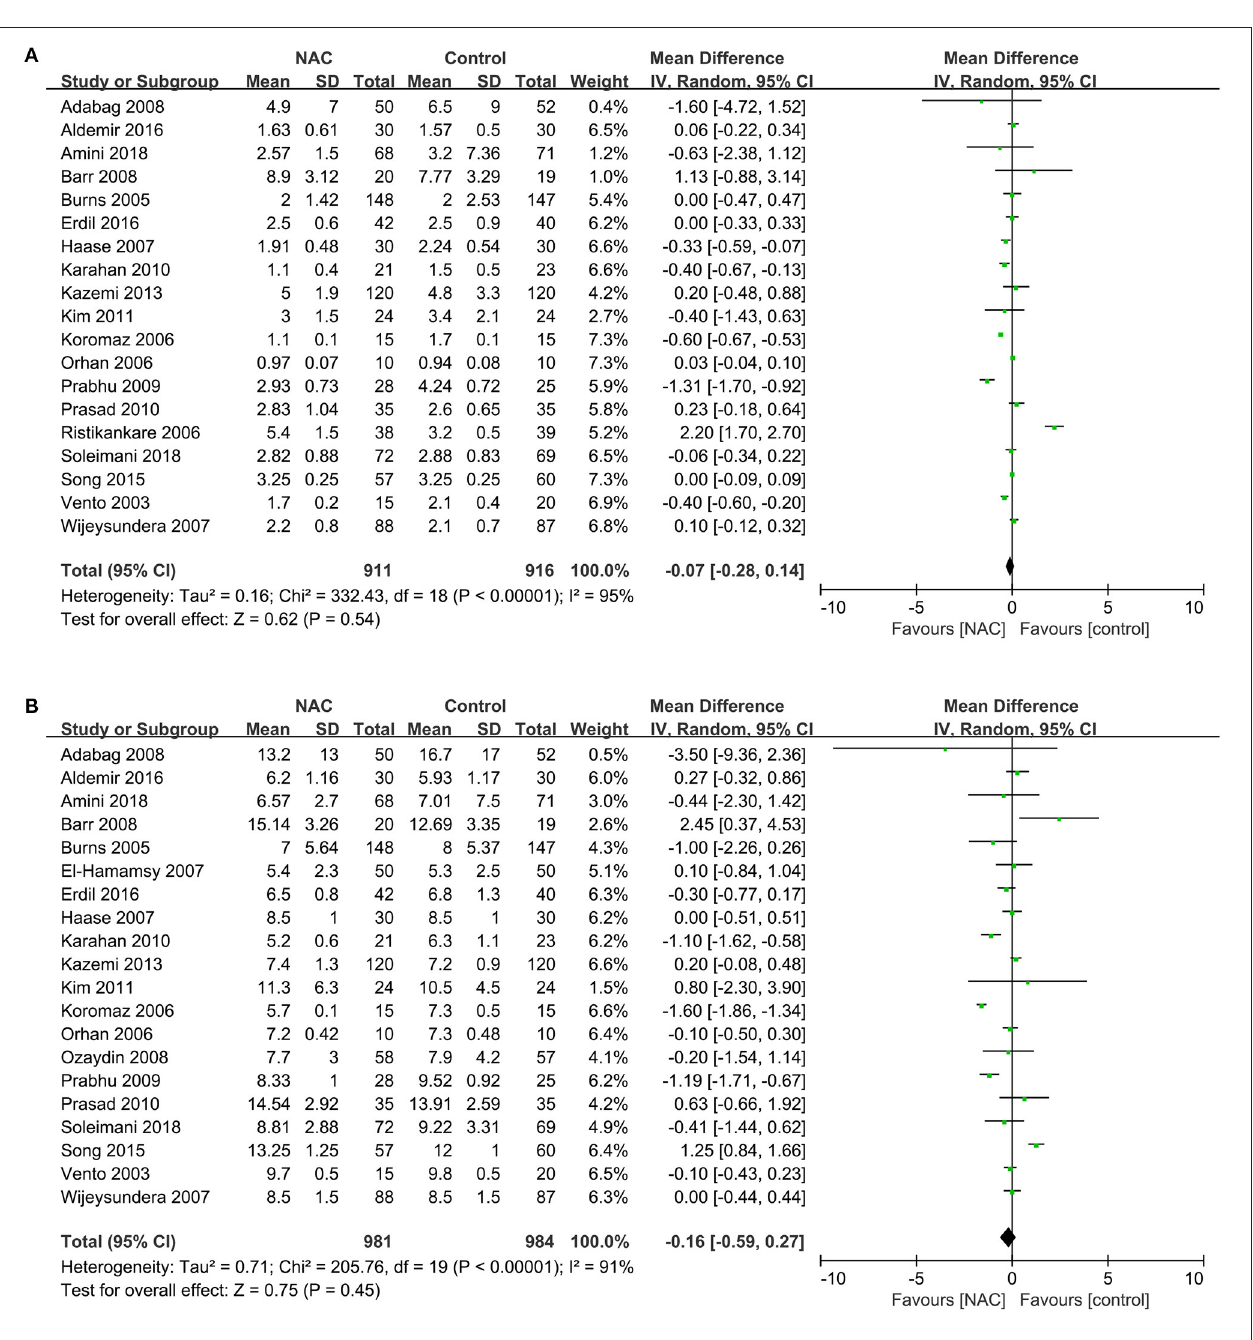
than that by oral administration. For example, Aldemir gave patients 150 mg.kg − 1 I.V. in 15 min after anesthesia